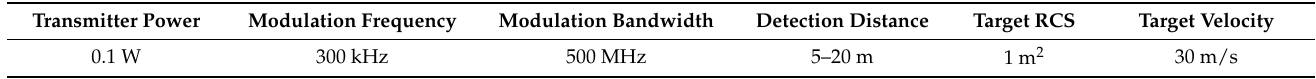
Table 2. The parameters of the circuit model.